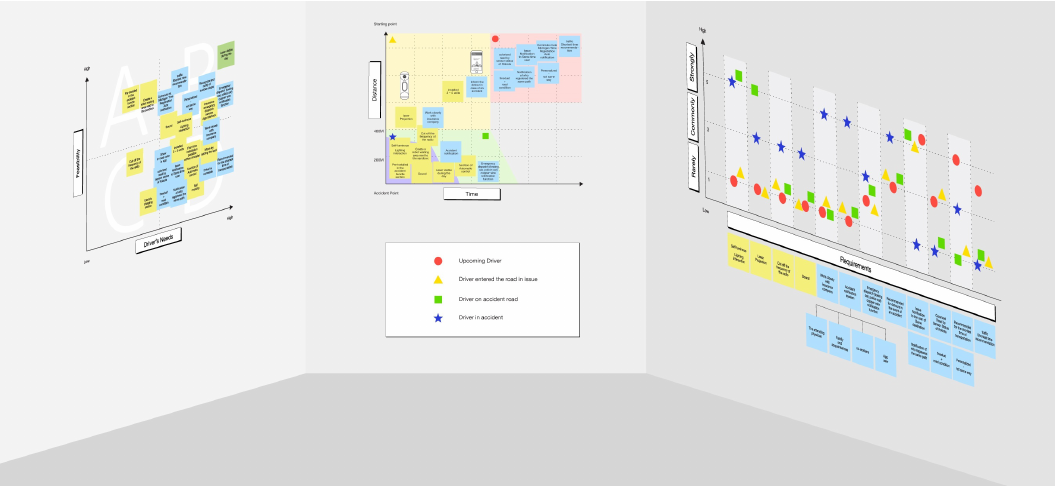
Table 1. User observation research with interview Goal